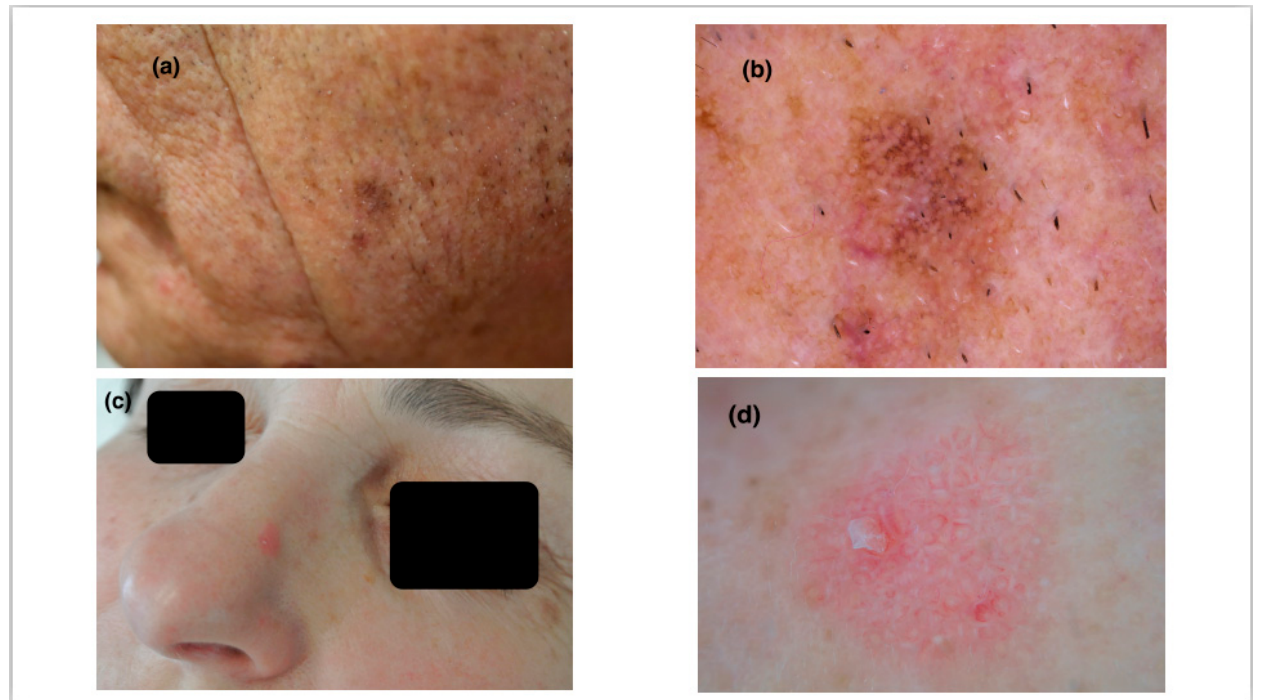
Figure 1. ( a ) A 67-year-old male patient with a pigmented scaly plaque on the left lateral side of the face. ( b ) Pigmented pseudo-network and widened follicular openings along with fine scaling demonstrate a typical pigmented actinic keratosis of the face. ( c ) A 62-year-old female patient with a pink, slightly elevated plaque on the nose. ( d ) A red pseudo-network surrounding widened follicular ostia and yellowish dots are features of a non-pigmented actinic keratosis. Linear wavy vessels can also be observed.